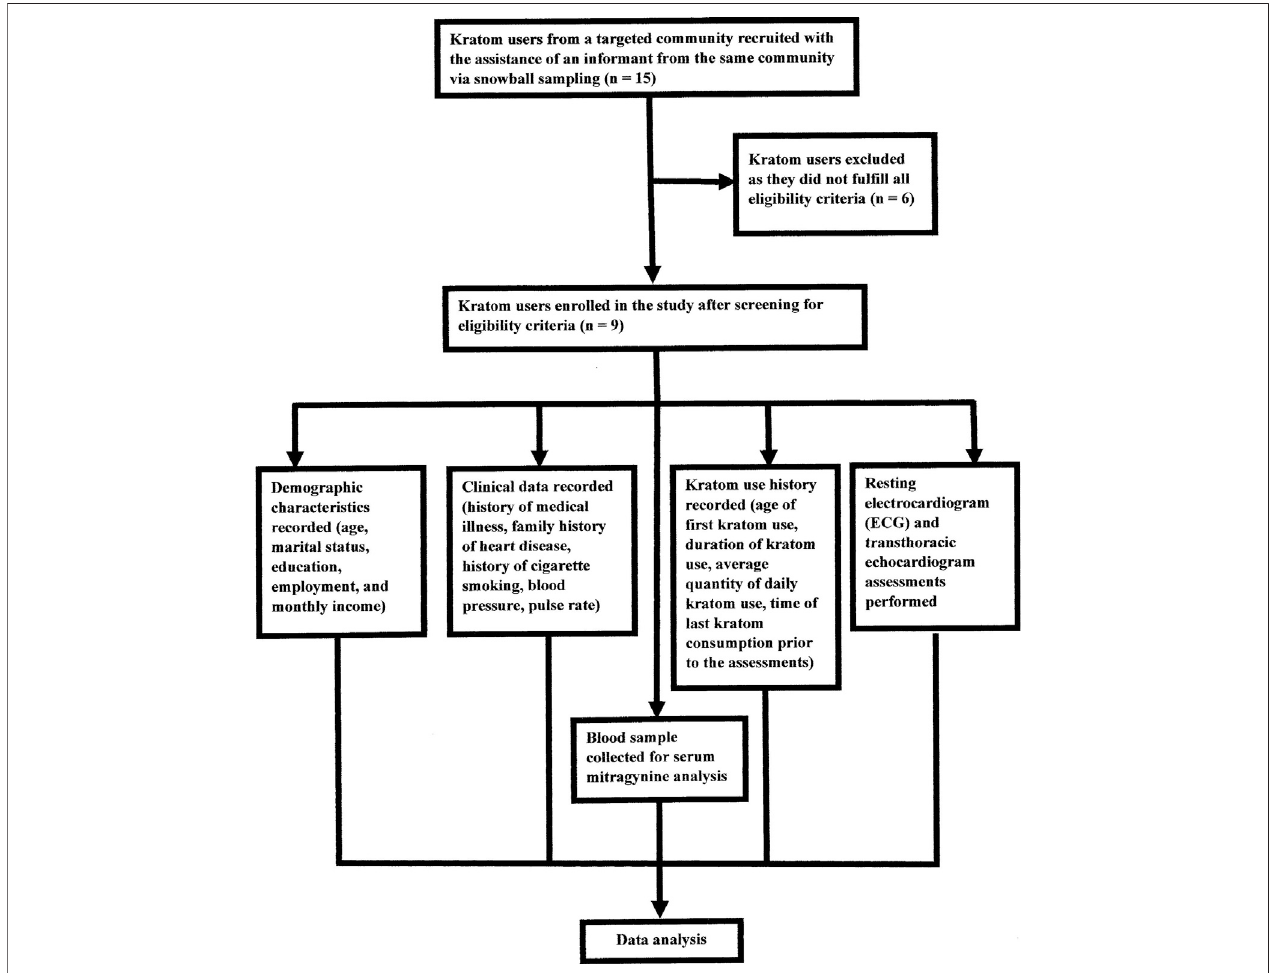
FIGURE 1 | Schematic presentation of the study